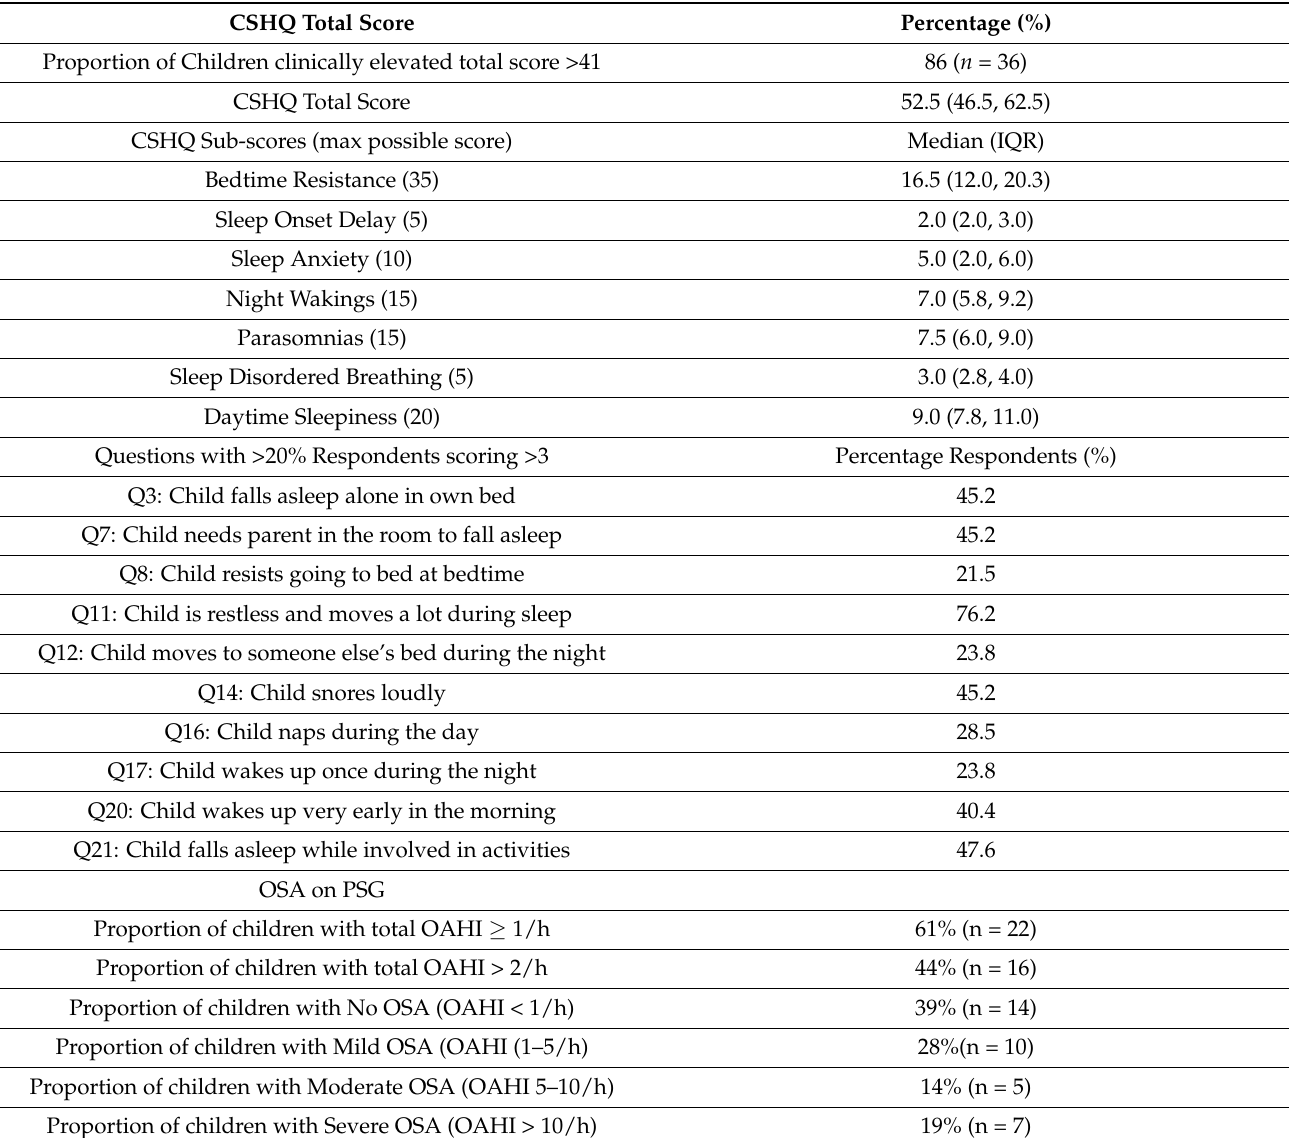
Table 2. Sleep data (CSHQ n = 42 and PSG n = 36) for